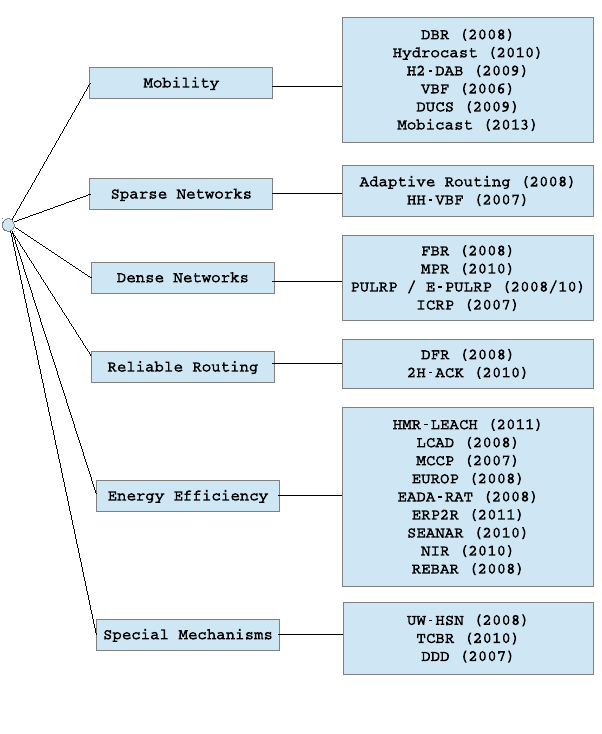
Figure 6. Classification of routing